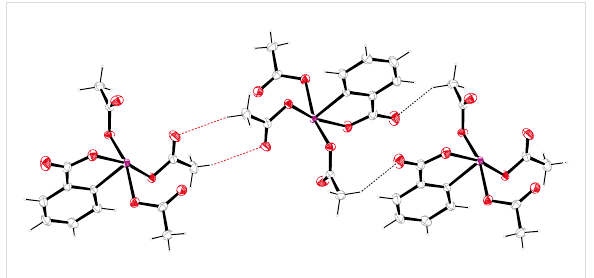
Figure 4: Further hydrogen-bond interactions in the supramolecular structure of 1 .